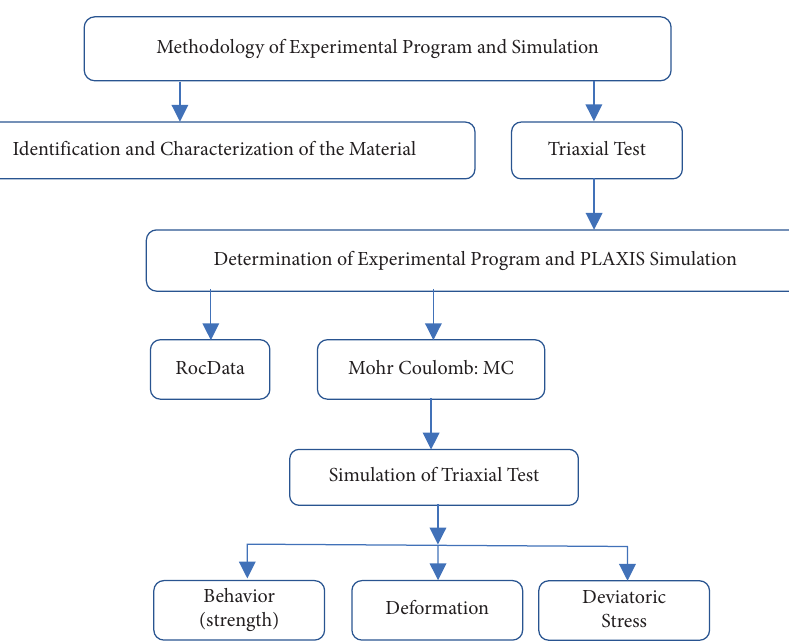
Figure 9: Methodology chart of the experimental and the numerical modelling.